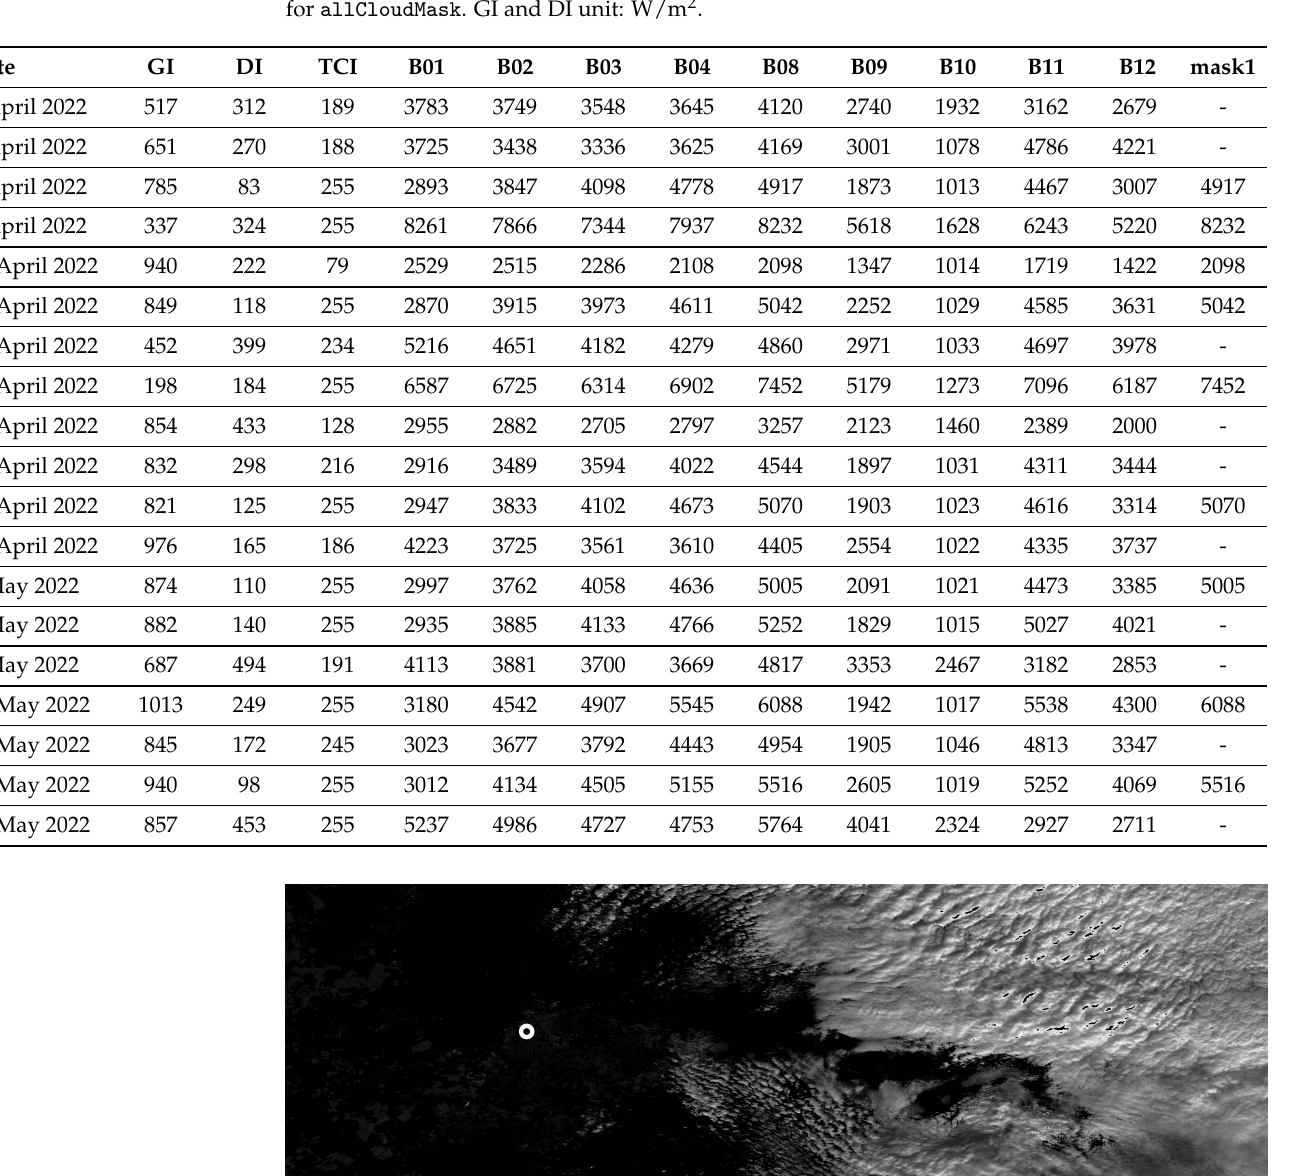
Figure 5. Example of a mask of low clouds detected on 1st January 2022 near Timisoara (marked with a